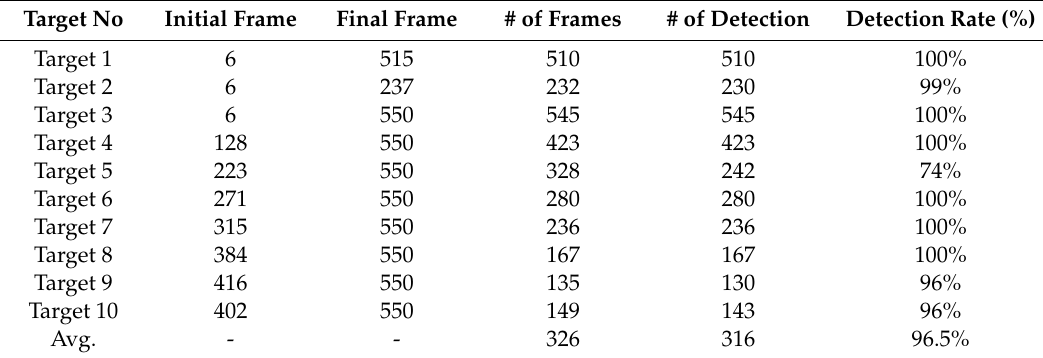
Table 2. Detection results.